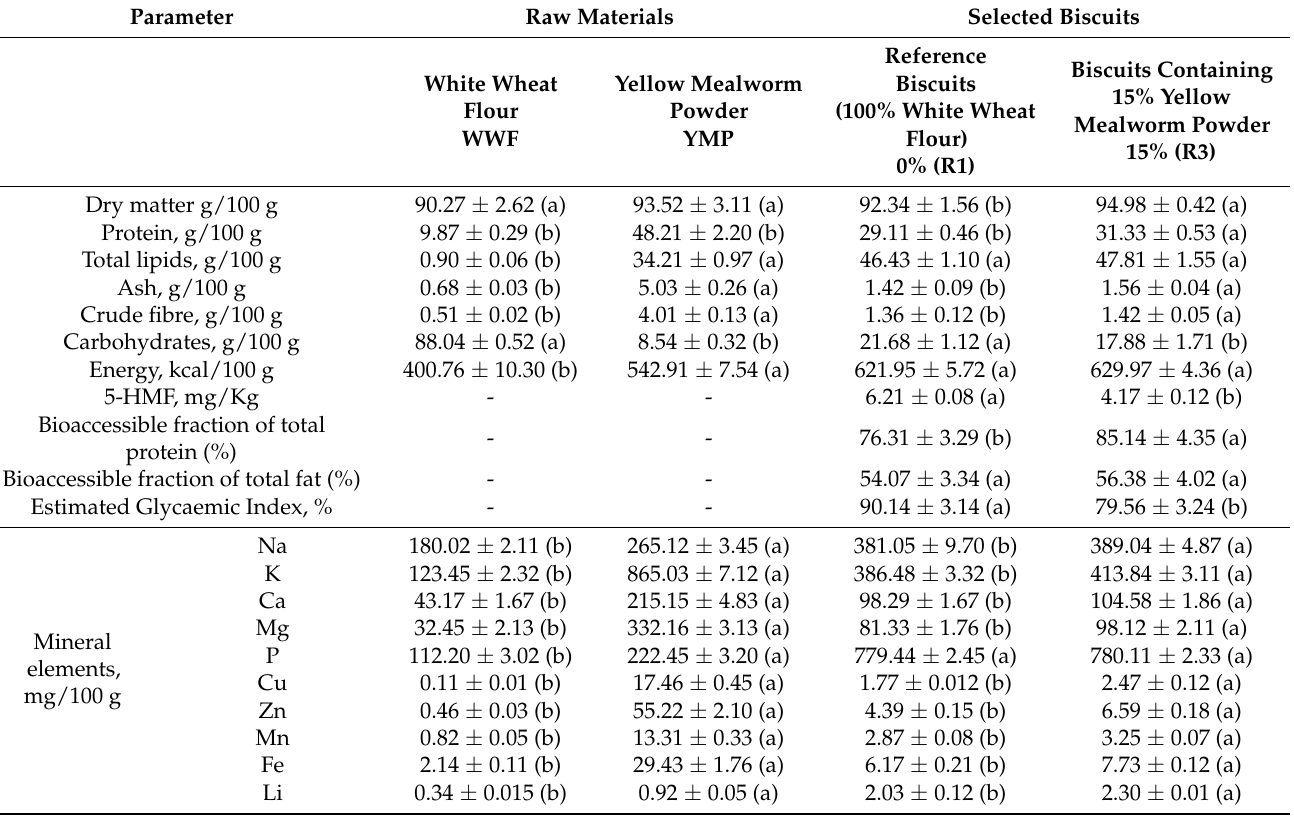
Table 2. Proximate analysis of white wheat flour, yellow mealworm powder, and selected biscuits. Parameter Raw Materials Selected Biscuits White Wheat Yellow Mealworm Flour Powder WWF